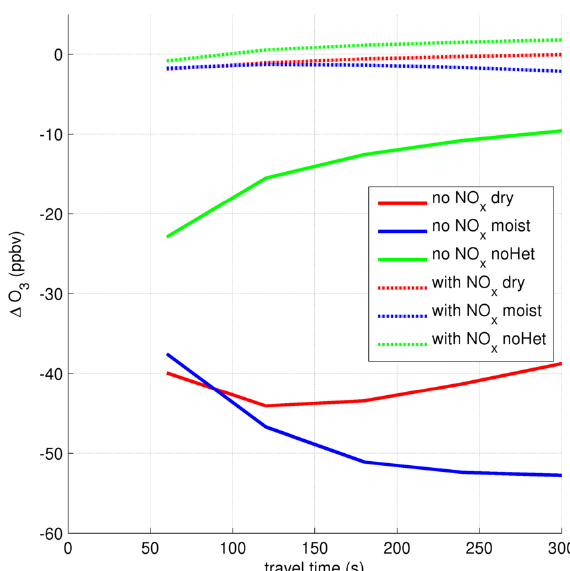
Figure 6. Modelled SO 2 mixing ratio in the plume core (“low Br / S” initialisation). Figure 7. Evolution of (cid:49) O 3 in the core of the plume for the six model scenarios discussed in the text (“low Br / S”